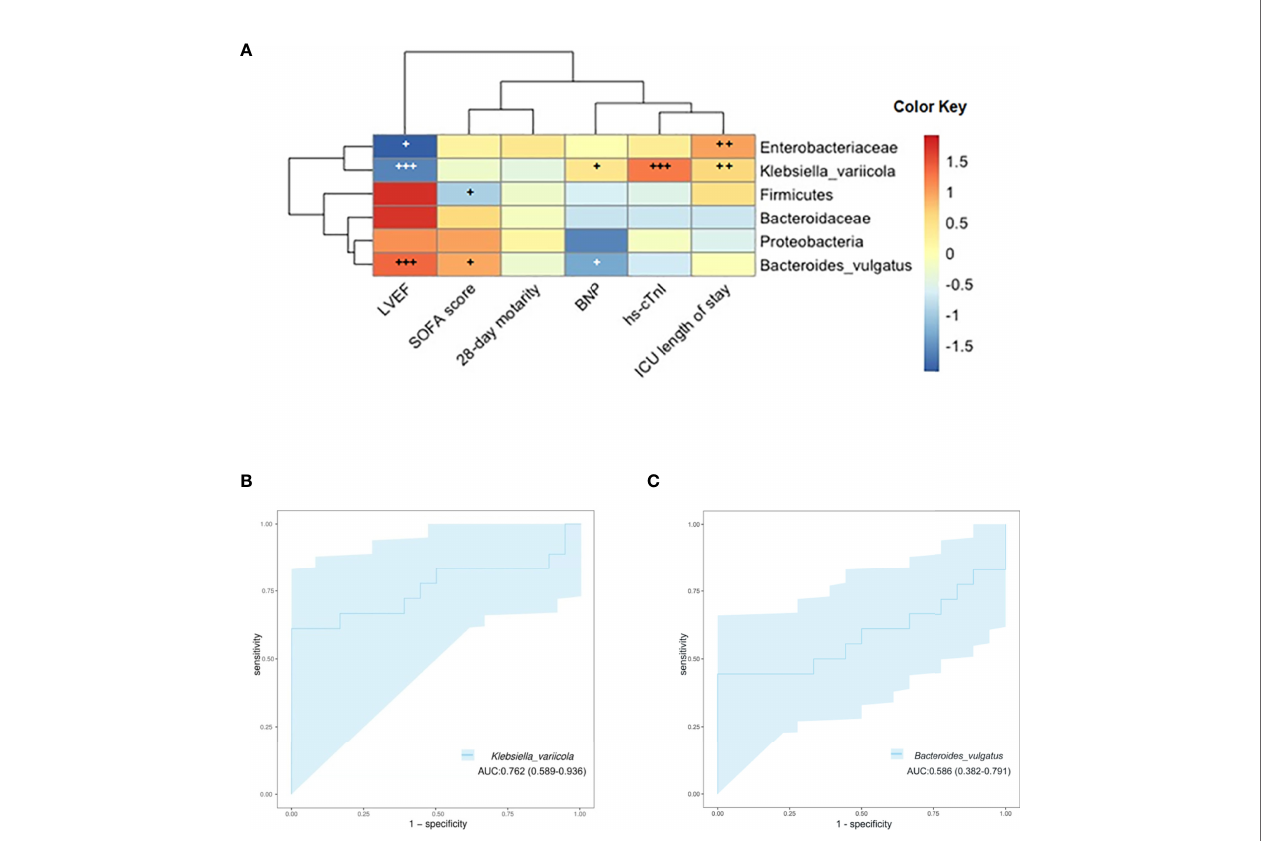
FIGURE 6 | (A) Associations of speci fi c microbiota in different levels with clinical characteristics. The heat map of Spearman ’ s rank correlation coef fi cients between the gut microbiota and clinical indicators (+, p < 0.10; ++, p < 0.05; +++, p < 0.01; LVEF, left ventricular ejection fraction; SOFA, Sequential Organ Failure Assessment; BNP, brain natriuretic peptide; hs-cTnI, high-sensitivity cardiac troponin I). (B) ROC curve showing the ability of Klebsiella variicola to predict SIMD. (C) ROC curve showing the ability of Bacteroides vulgatus to predict SIMD. ROC, receiver operating characteristic; SIMD, sepsis-induced myocardial